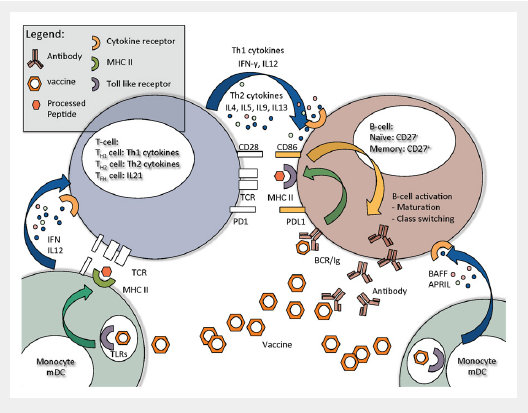
Key steps in B-cell activation and B-cell interaction with T-helper cells and monocytes, and monocyte derived macrophages and dendritic